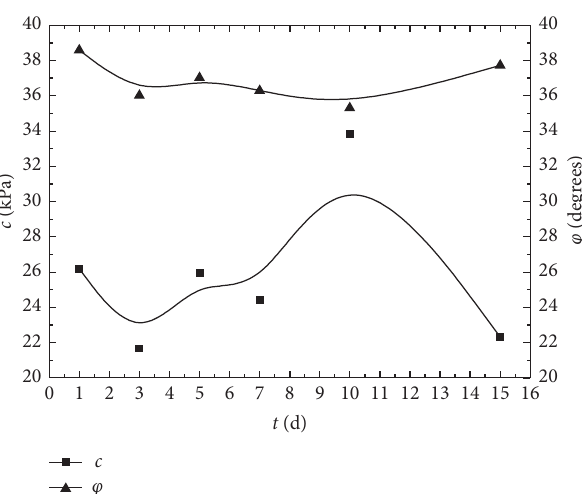
Figure 3: Variable characteristics of the cohesive force and internal friction angle under acid